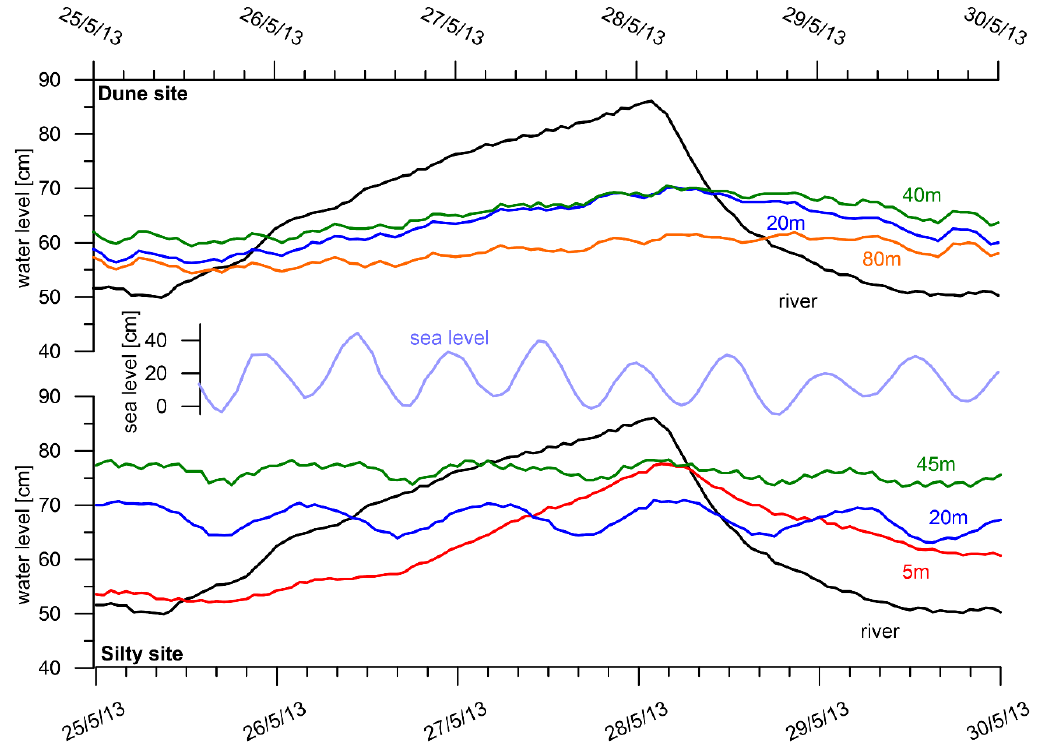
Figure 5. Enlargement of Figure 3 for the response of groundwater to a single summer river event (late May 2013) at both sites. Numbers denote distance from the river in meters.